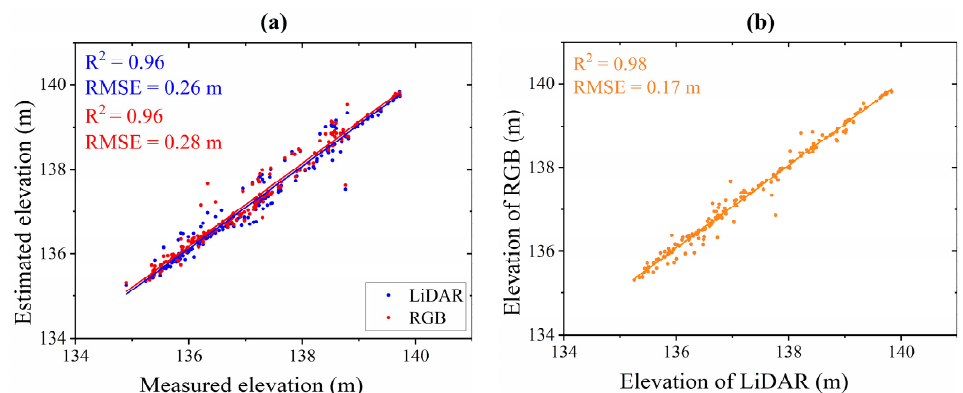
Figure 4. Correlation graph: ( a ) correlation between the field-measured elevation and the corresponding elevation values of DEM R and DEM L ; ( b ) correlation between the elevation values of DEM R and DEM L .